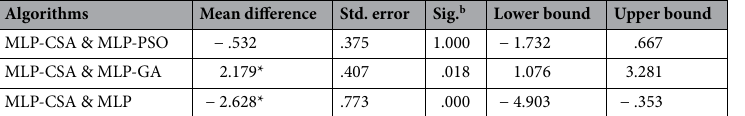
Algorithms Mean difference Std. error Sig. b